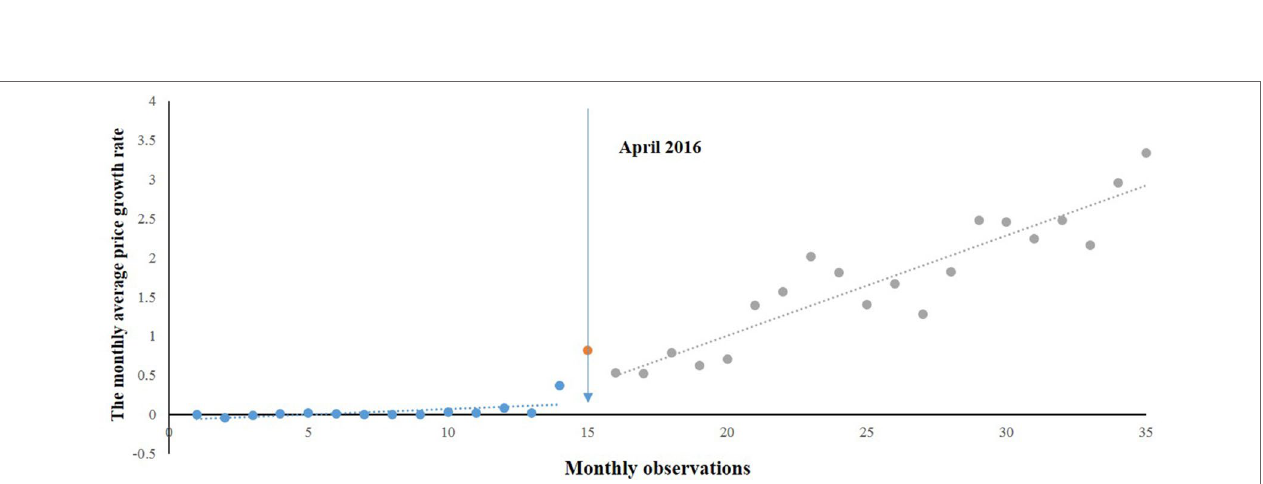
FIGURE 2 | Segmented regression model showing MPRe from 2015 to 2017.